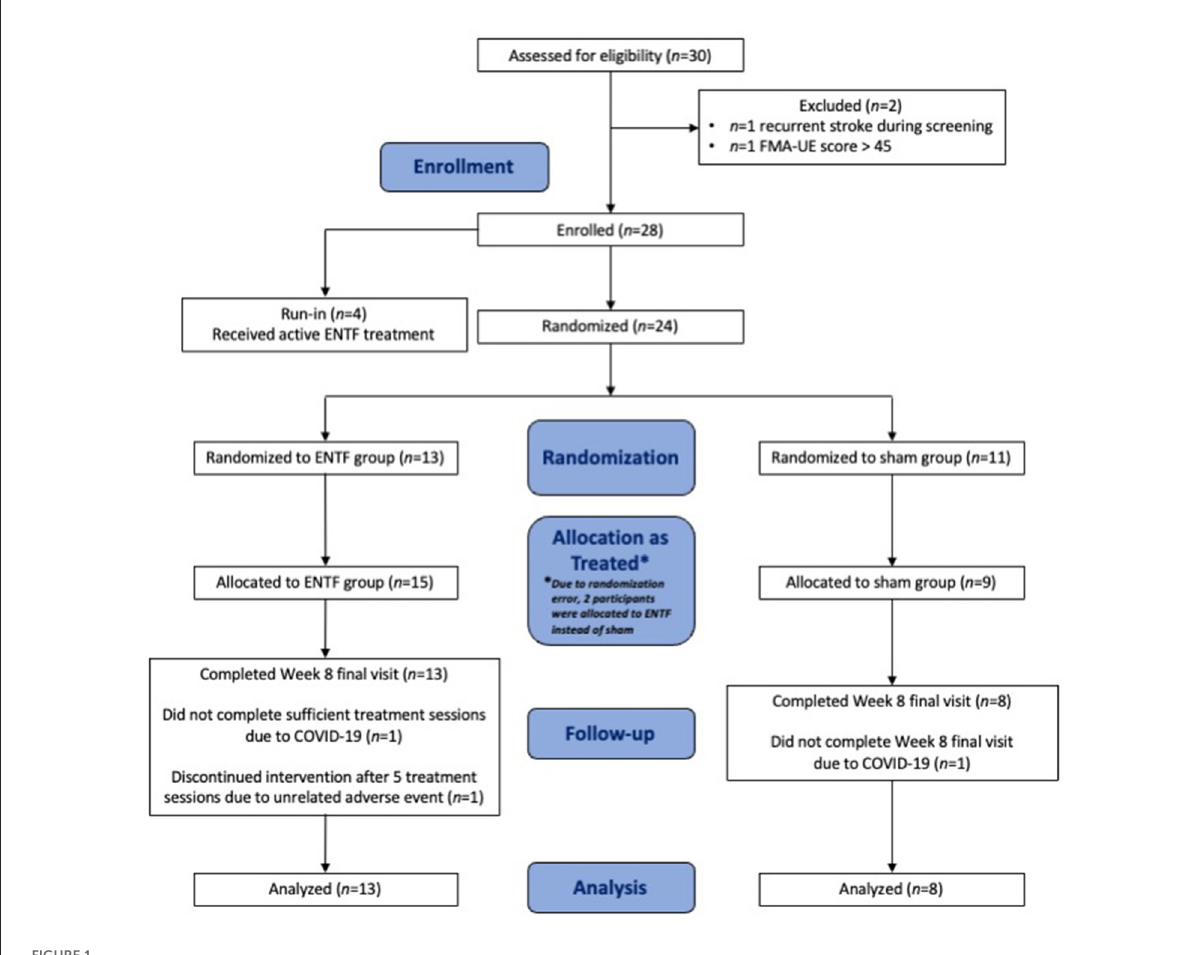
FIGURE1 Participant study flow